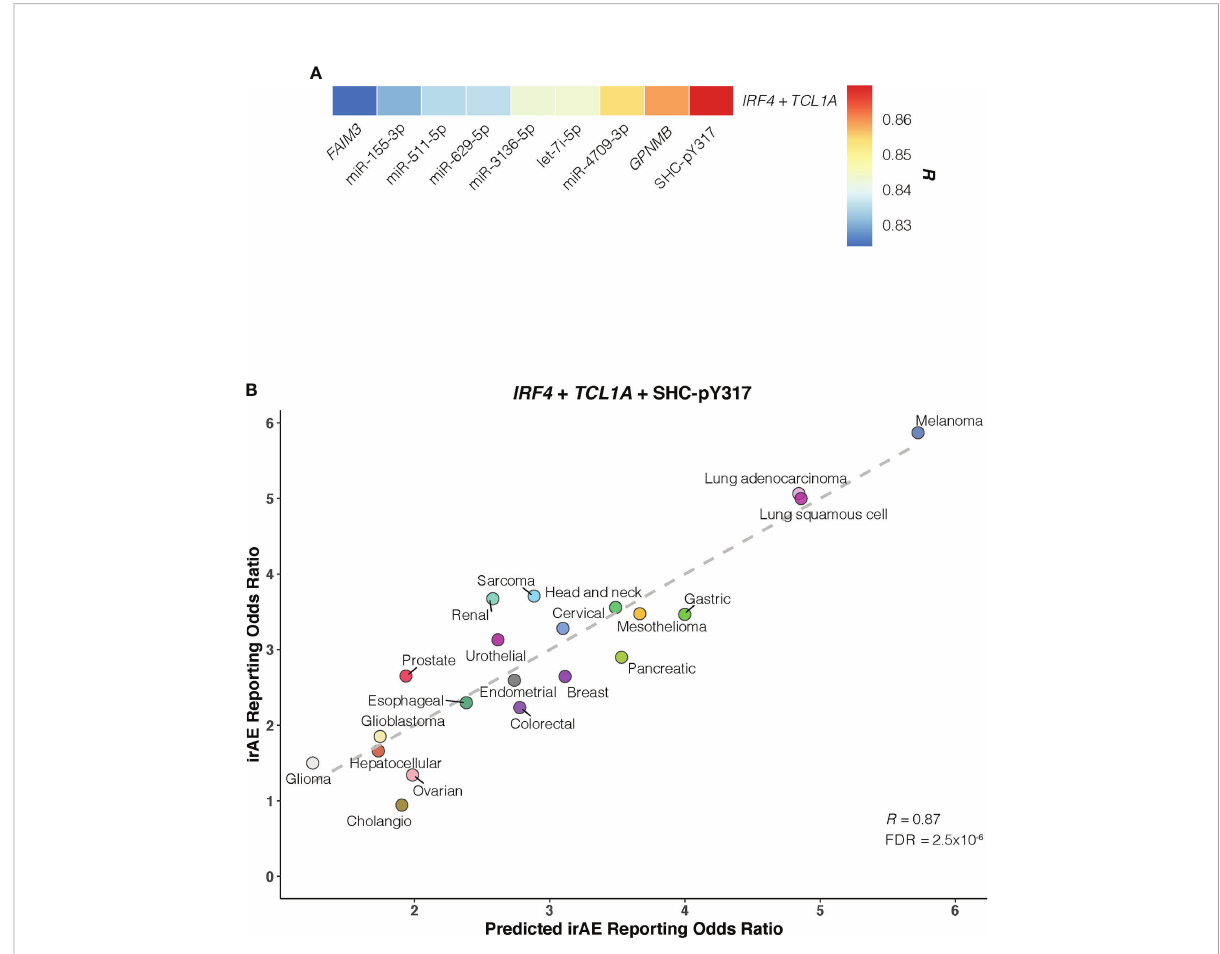
FIGURE 5 Optimal IRF4 – TCL1A – SHC-pY317 Model in Predicting Immune-Related Adverse Events for Anti – PD-1 Therapy Across Cancer Types. (A) , Comparison of predictive performance given by the IRF4 and TCL1A genes together with other immune-related adverse events (irAEs)- associated molecular factors. Pearson correlation coef fi cient ( R ) is represented in colors from blue to red as shown in the color bar. (B) , Combined effect of IRF4 – TCL1A – SHC-pY317 trivariate model. The dashed line depicts the linear fi t, with the formula reporting odds ratio = 0.28 × IRF4 + 0.47 × TCL1A – 2.39 × SHC-pY317 + 0.77. Cancer types are depicted in distinct